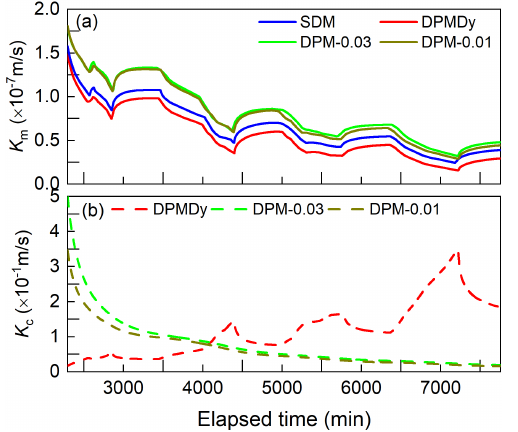
Figure 17. Variation of boundary K m and K c in each model during the fifth drying periods. (a) K m and (b) K c .